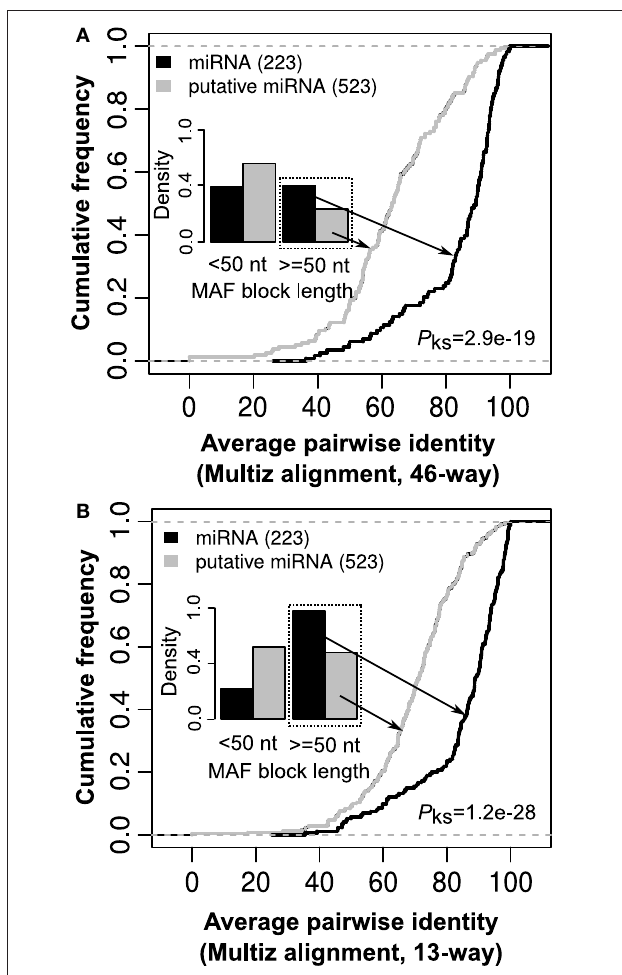
FIGURE 6 | The length and average pairwise identity for Multiz alignments corresponding to known and putative miRNAs. (A) In comparison to known miRNAs, most putative miRNAs have Multiz alignment [46-way downloaded from UCSC (Karolchik et al., 2004)] of length < 50 nt and rest have a significantly low average pairwise identity ( p -value = 2.9e-19, Kolmogorov–Smirnov test). (B) For the in house 13-way Multiz alignments (Anthon et al., in preparation), the same pattern was observed with putative miRNAs either have Multiz alignments that are short ( < 50 nt) or have a significantly lower average pairwise identity in comparison to known miRNAs ( p -value = 1.2e-28, Kolmogorov–Smirnov test). This suggests that absence of well-defined Multiz alignments may contribute to many of these putative miRNAs not being identified